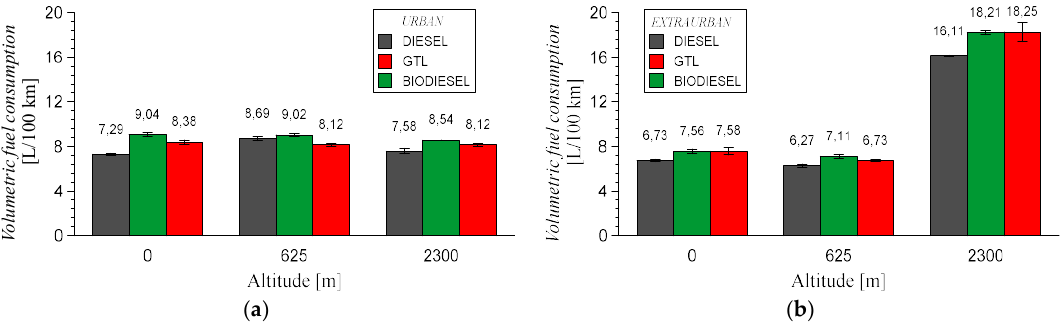
Figure 11. Volumetric fuel consumption: ( a ) Urban driving conditions, ( b ) Extra-urban driving conditions